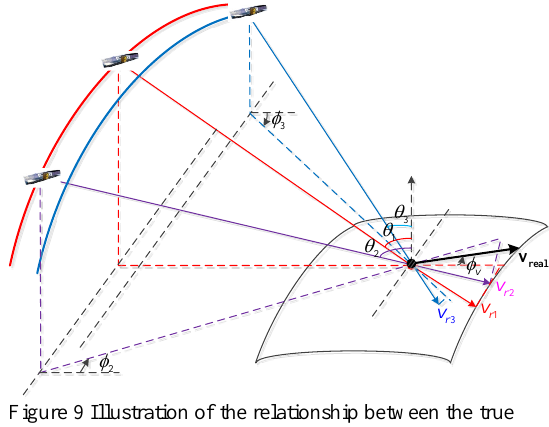
Figure 9 Illustration of the relationship between the true velocity and the radial velocity of a moving